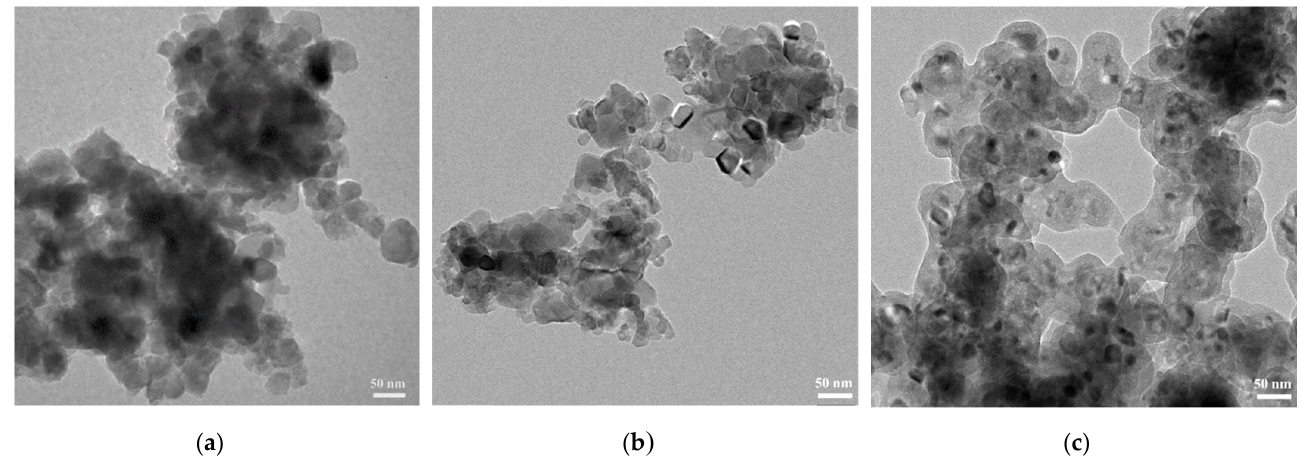
Figure 1. XRD patterns of SiO 2 , TiO 2 , N-TiO 2 , and N-TiO 2 @SiO 2 .